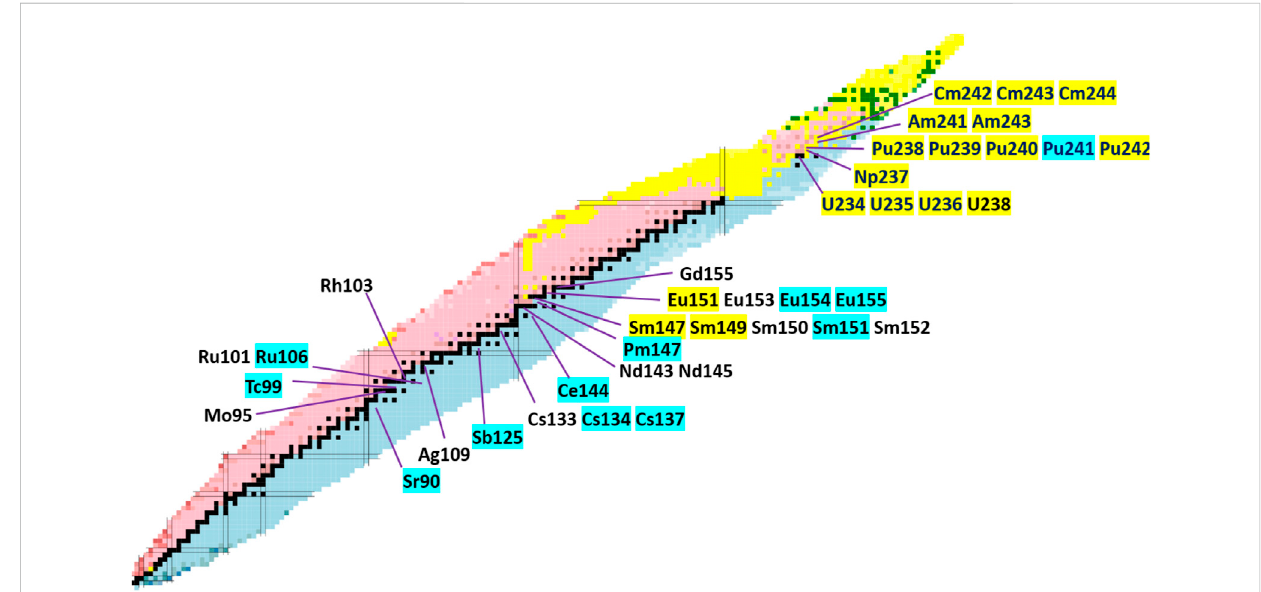
FIGURE 4 Nuclidesofinterestidenti fi edin(IAEA-TECDOC-1241,2001),(Sirakovetal.,2017)relevantforcriticality,burnupcreditanddoserate(primarydecay modes in yellow: α ; black: stable; blue: β -